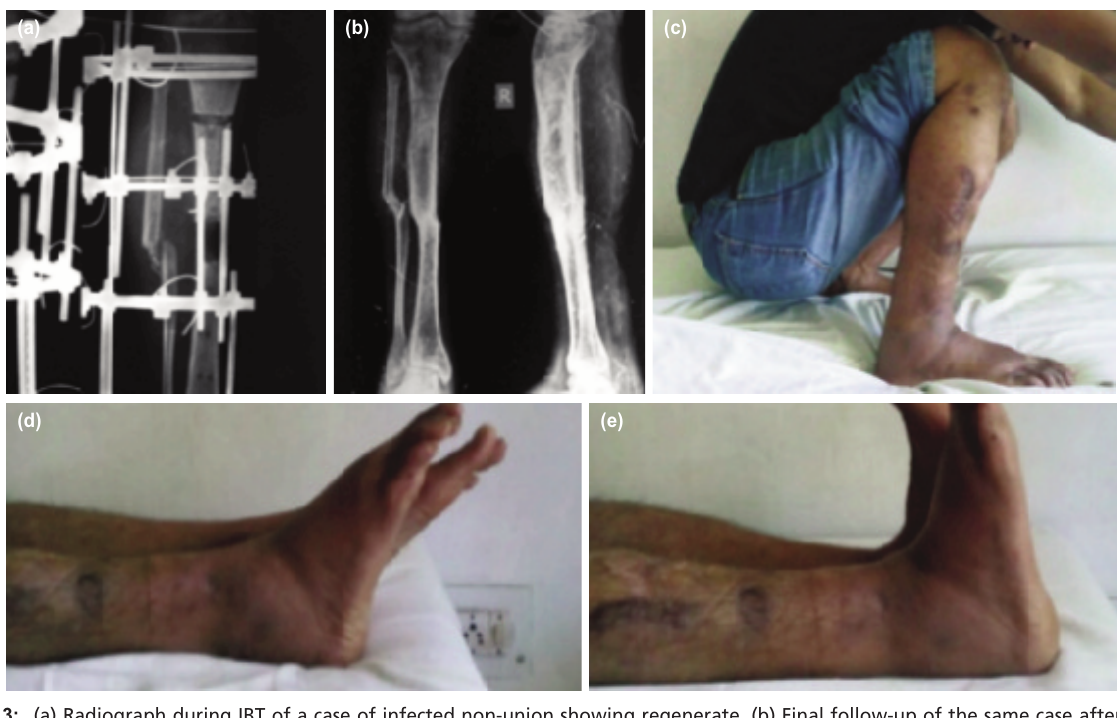
(a) Radiograph during IBT of a case of infected non-union showing regenerate. (b) Final follow-up of the same case after ring Fig. 3: removal. (c) Clinical picture at final follow-up showing ROM of knee joint. (d) Clinical picture at final follow-up showing ankle plantar flexion. (e) Clinical picture at final follow-up showing ankle dorsiflexion.